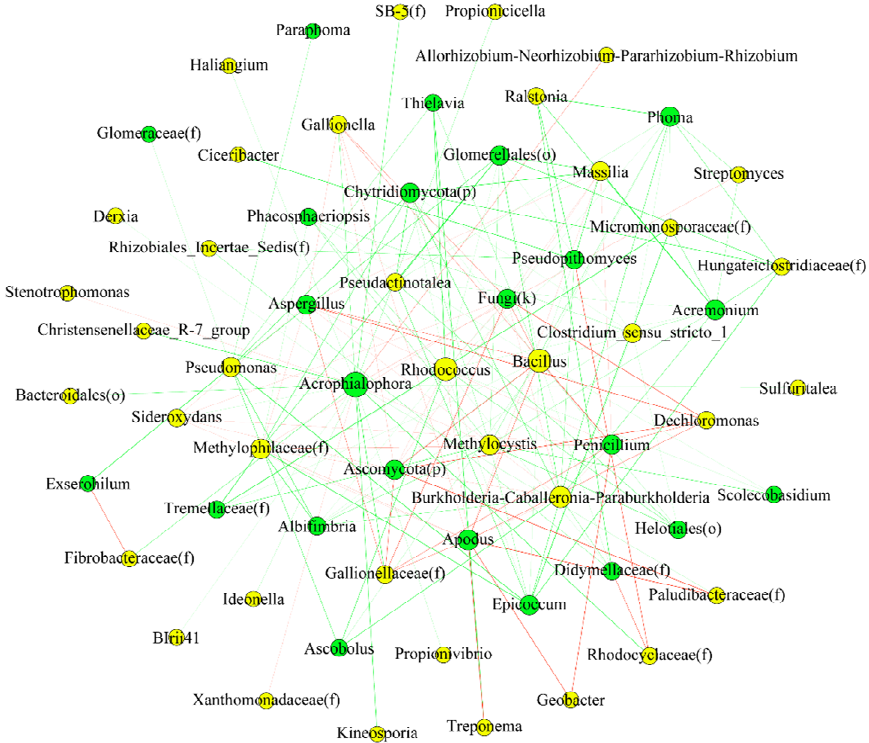
Figure 9. Correlation network diagram of bacteria and fungi at the genus level in barnyardgrass .